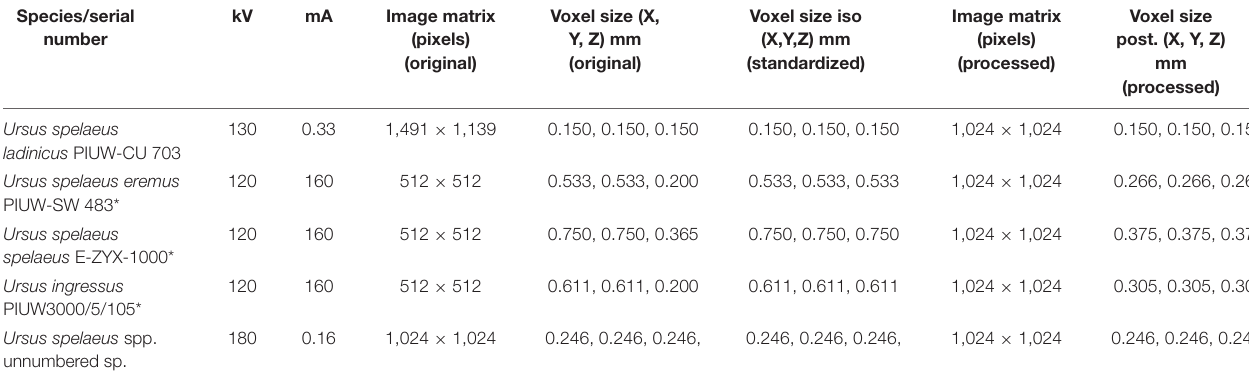
TABLE 1 | XCT scan acquisition parameters of each skull belonging to the extinct bears used in this article as an example. Species/serial